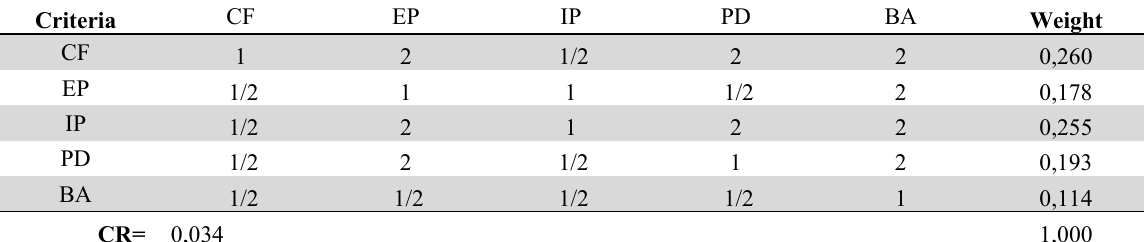
Pairwise comparison matrix aggregation for Governance Capability